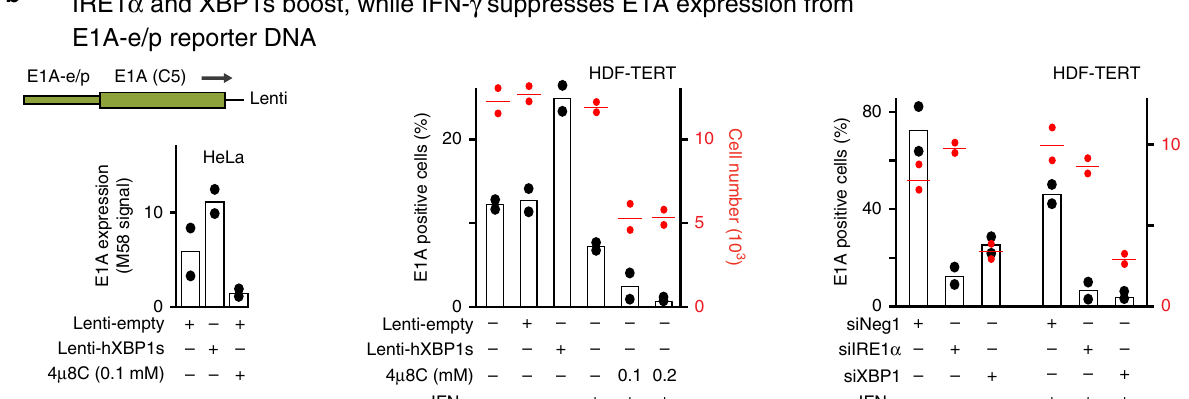
+–– –– 0.1–– – –– +––siIRE1 α + – –– – 0.2 4 μ 8C (mM) Fig. 5 XBP1s enhancement of E1A and 19K levels depends on the E1A promoter. a The expression of human XBP1s (hXBP1s) enhances E1A and 19K expression and infection. Dose-dependent expression of hXBP1s in HeLa I-KO (IRE1 α -knockout) cells transduced with lentivirus vectors for 72 h ( fi rst panel). AdV-C2-dE3b-mCherry infection (MOI 100) is rescued in HeLa I-KO cells by hXBP1s expression, where the cells were transduced with lentiviruses for 2 days and infected with AdV-C2 for 24 h (second panel). Data are presented as mean from two technical replicates, and two independent experiments gave similar results. qrt-PCR showing the rescue of E1A mRNA by hXBP1s overexpression in AdV-C2-(MOI 75) infected HeLa I-KO cells. Data are presented as mean ± SD from three independent experiments (third panel). Increased 19K protein levels by hXBP1s expression in AdV-C2-(MOI 75) infected HeLa I-KO cells ( n = 3627 and 2317 for lenti-empty and lenti-hXBP1s, respectively, fourth panel). Data show the medians and fi rst and third quartiles, and whiskers as boxes and lines, respectively. Statistical analyses were done by two-tailed Wilcoxon nonparametric tests with signi fi cance * p < 0.001. Two independent experiments gave similar results. b E1A expression from the E1A-e/p can be increased by ectopic XBP1s, or reduced by the IRE1 α inhibitor 4 µ 8C in HeLa cells (left panel). A similar experiment was carried out in HDF-TERT cells including IFN- γ to suppress the E1A promoter/enhancer expressed from a lentivirus vector (middle panel). E1A expression in HDF-TERT cells is reduced by RNA interference against IRE1 α and XBP1, but not by nontargeting siRNA (siNeg1, 20 nM siPools, right panel). Error bars represent standard deviations. For all the graphs, data are presented as mean from two technical replicates, and two independent experiments gave similar